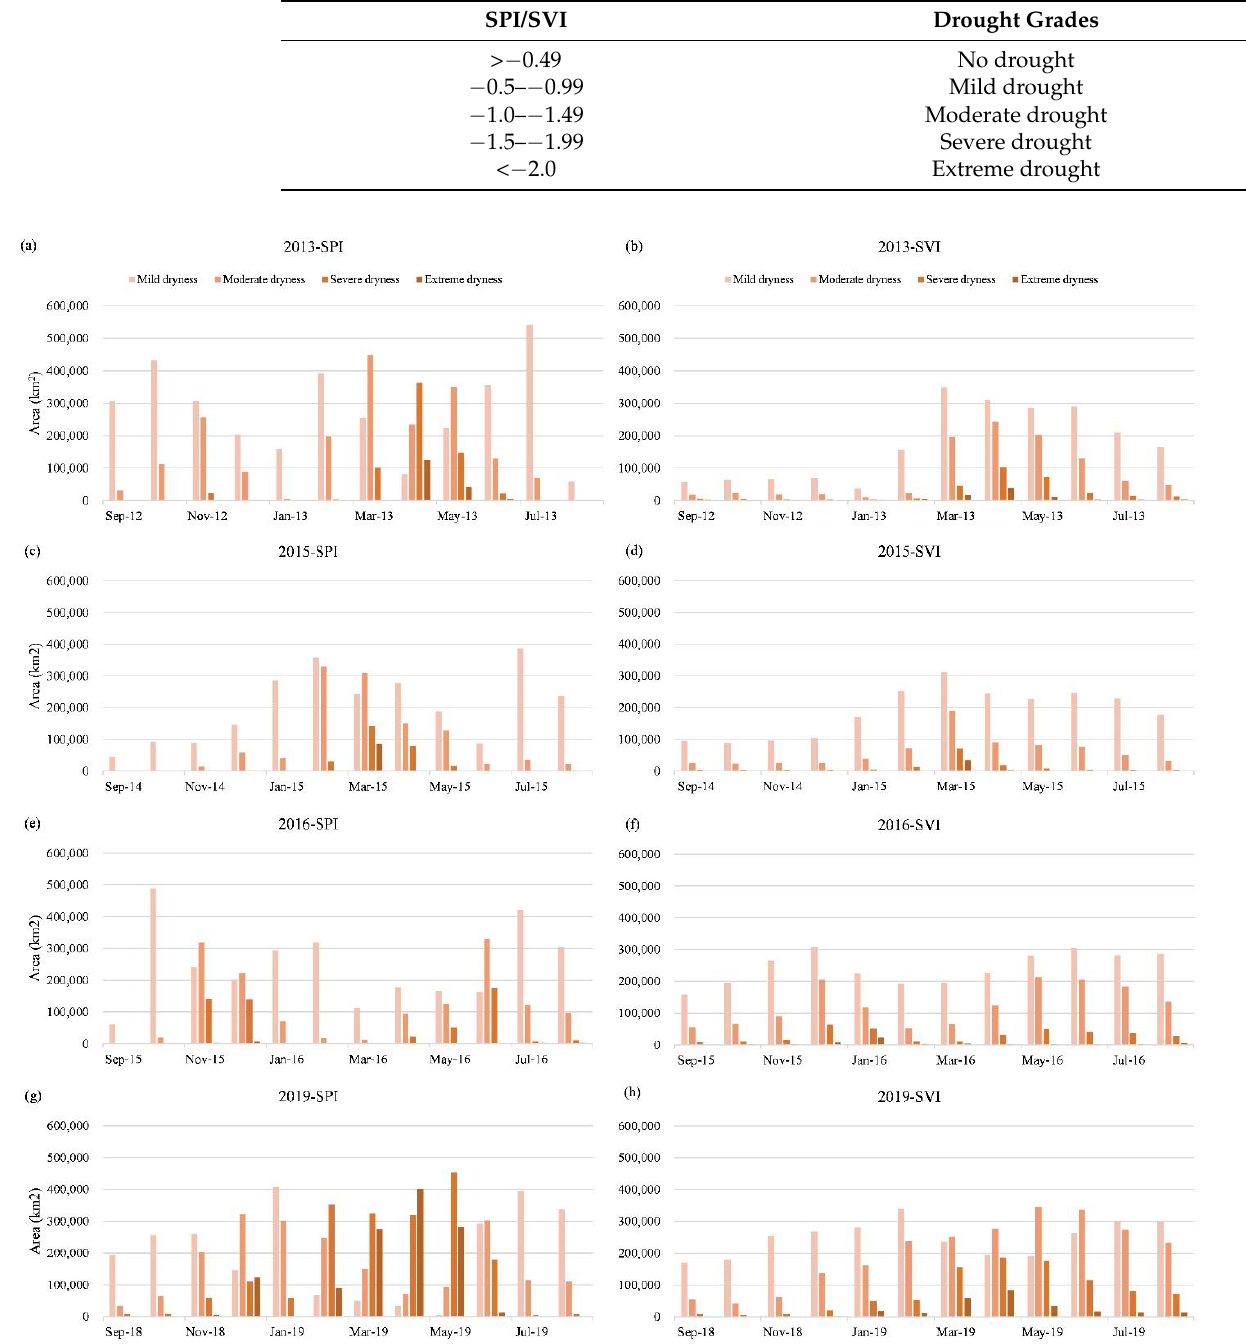
Table 1. Drought grades according to drought indies.